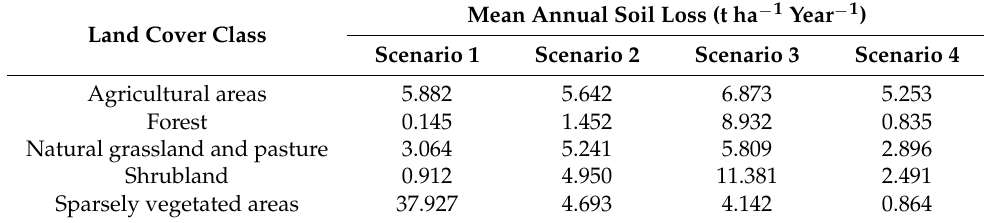
Table 9. Soil erosion rates in terms of land cover.